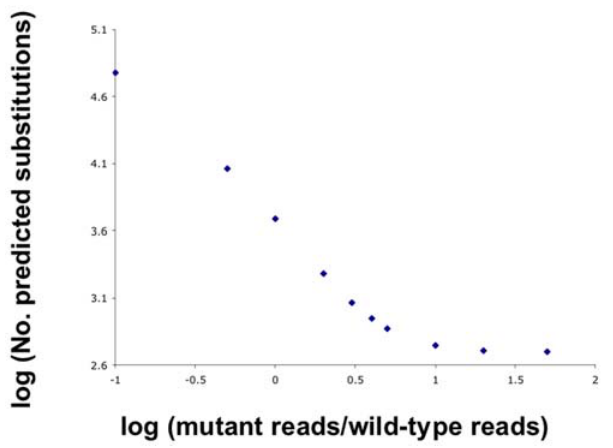
Figure 6. Empirical correlation of the number of SNP_search- predicted nucleotide substitutions with SNP_search parame- ters. The number of predicted nucleotide substitutions generated by SNP_search using the lsy-12 ( ot177 ) data [1] is shown as a function of the minimal ratio of the number of mutant and wild-type reads sufficient to trigger a SNP call. This ratio is a user-specified parameter. Numbers on each axis are the base 10 log of the actual values.